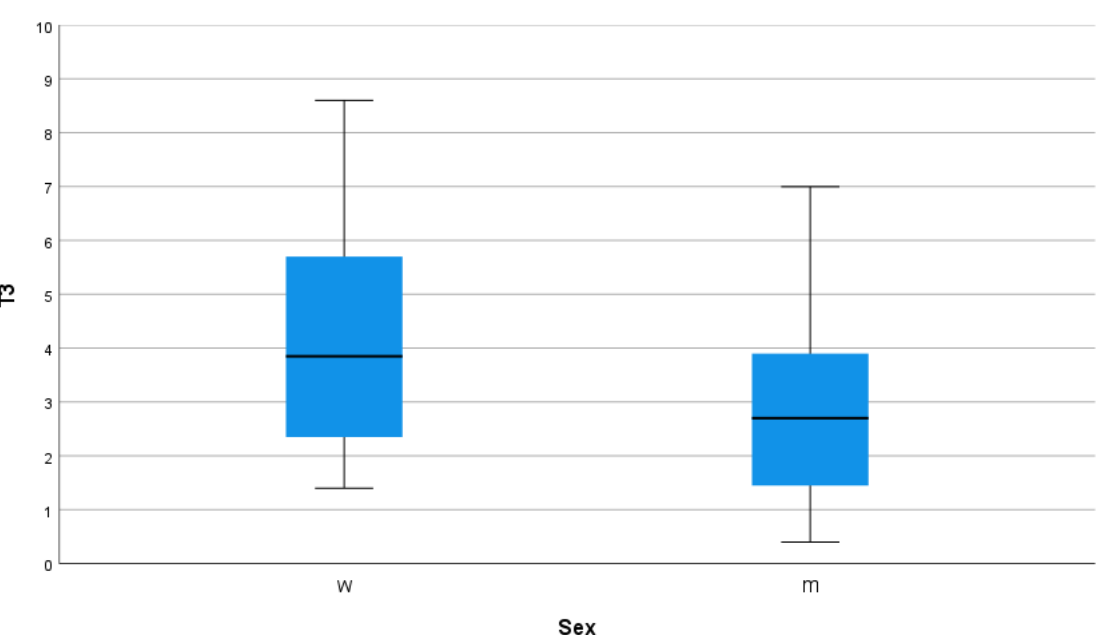
Figure 3. Boxplot over the total analyzed postoperative time and gender (w = women; m = men).